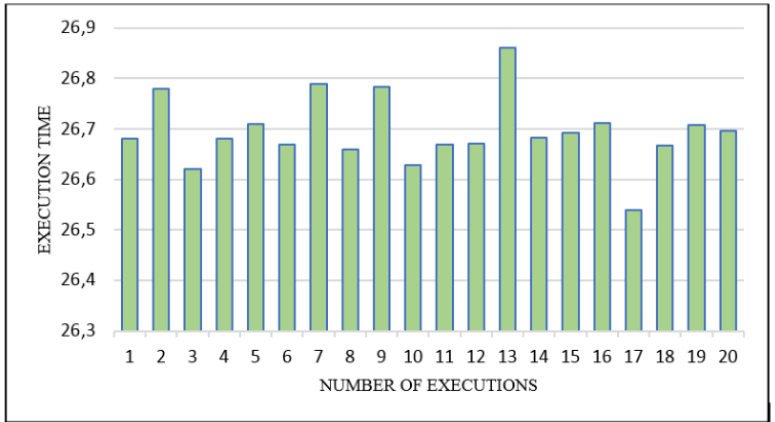
Figure 14. Execution time of pick and place task.